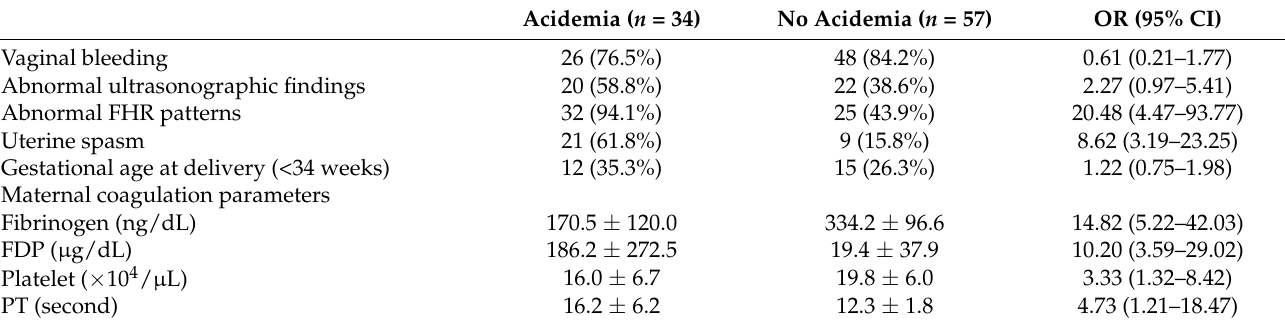
Table 2. Results of univariate analysis in terms of prediction factors of fetal